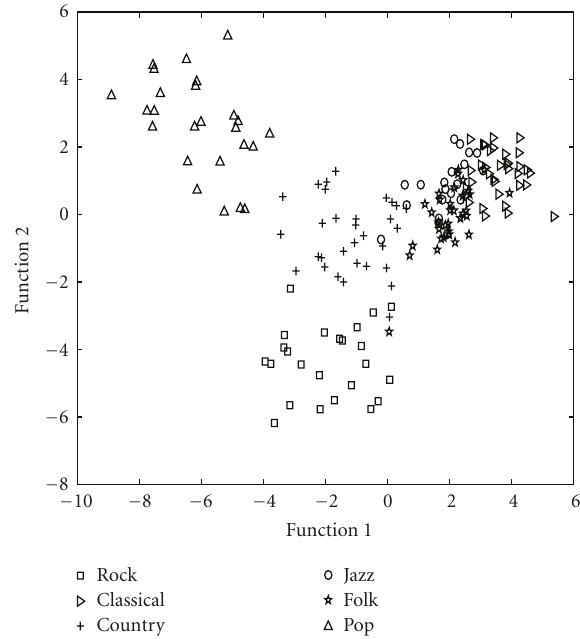
Figure 12: All-groups scatter plot with the first two canonical discriminant